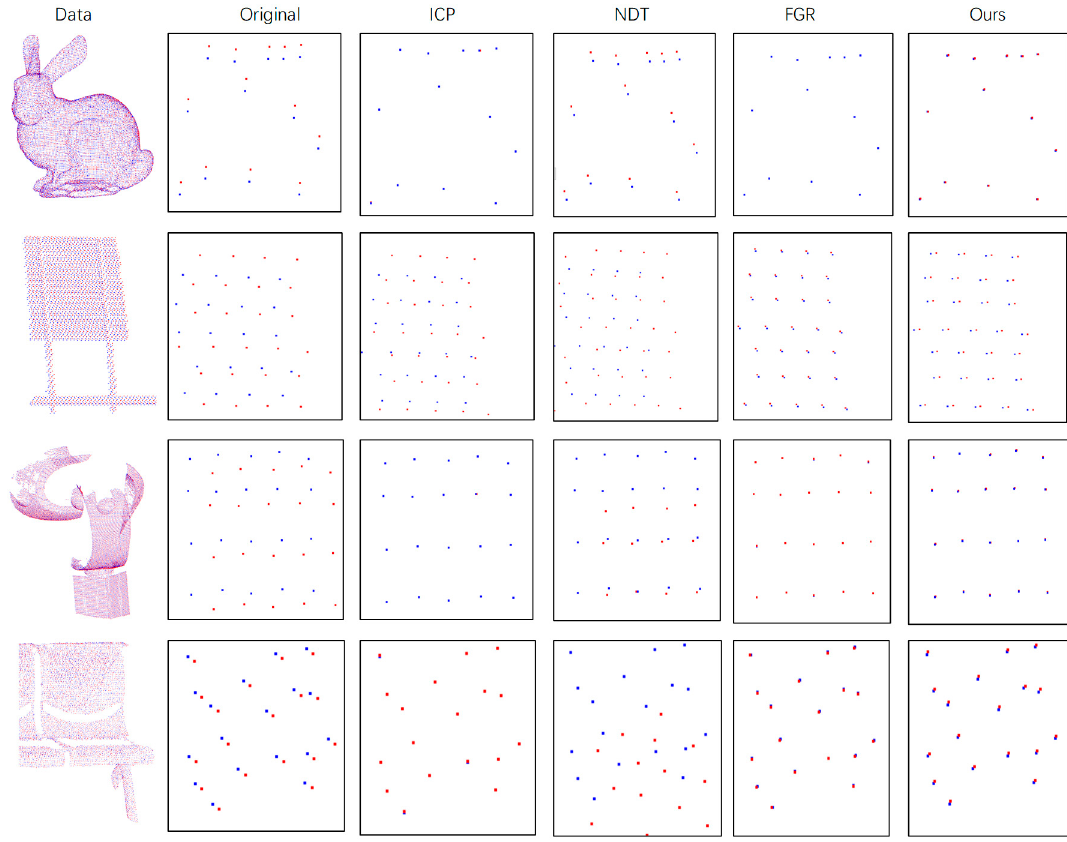
Figure 8. Performance on Clean Data. The first column on the left of the figure is the original point cloud data, the second column is the detailed schematic diagram and the rest are the detailed diagrams after registration by each method. Table 2. Performance on Different Resolution Data.